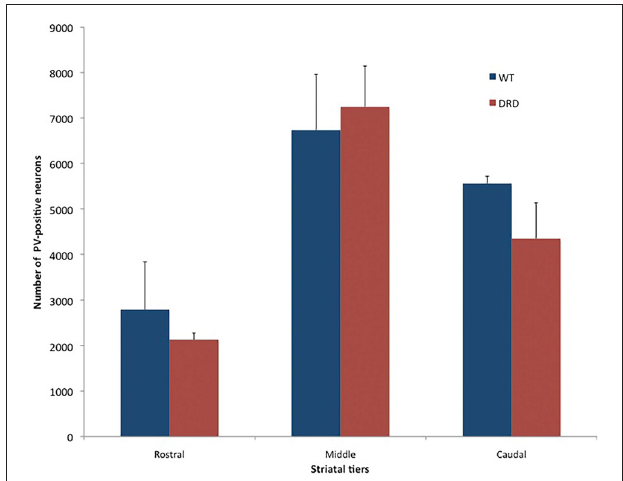
FIGURE 4 | Number of PV-positive neurons (average values ± SEM) in the rostral, middle and caudal tiers of the DS of young WT and DRD mice. No significant difference was found between the two groups.